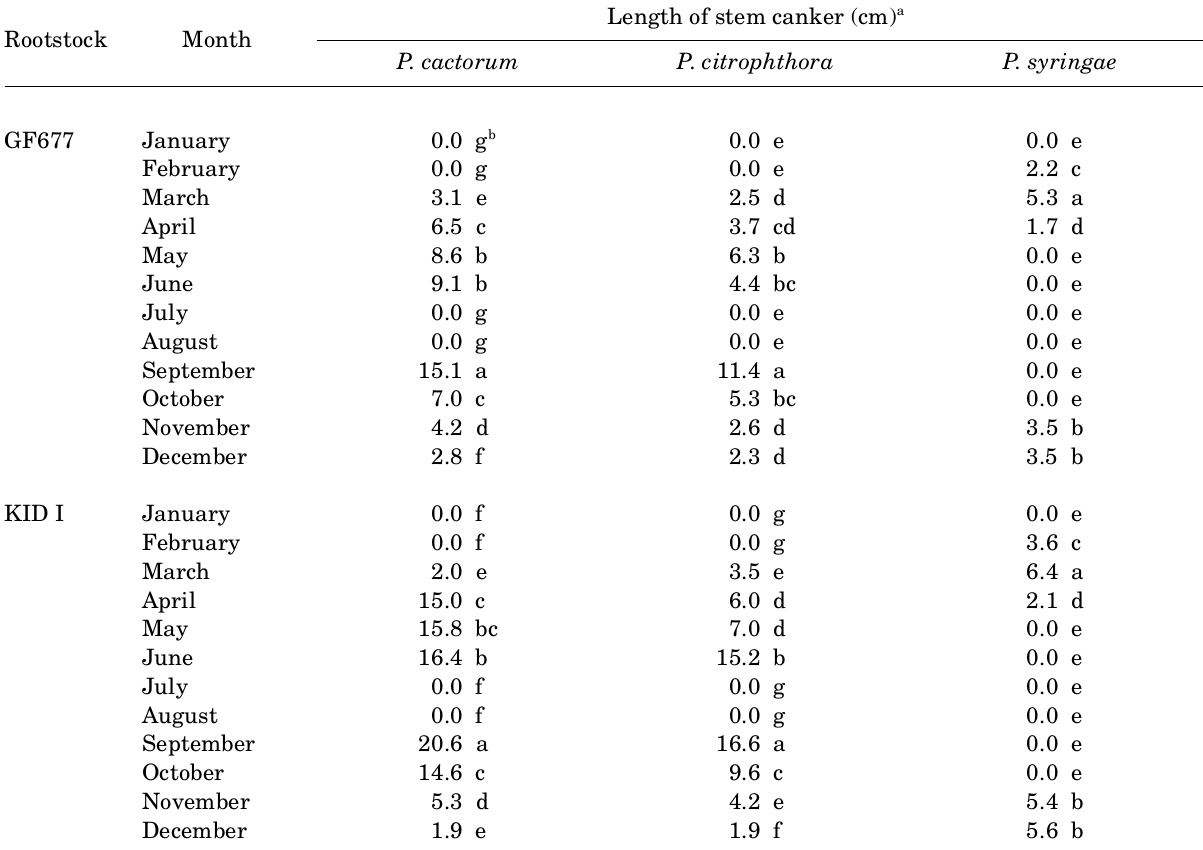
Table 2. Development of stem cankers on plants of peach rootstocks GF677 and KID I with P. cactorum , P. citroph- thora and P.